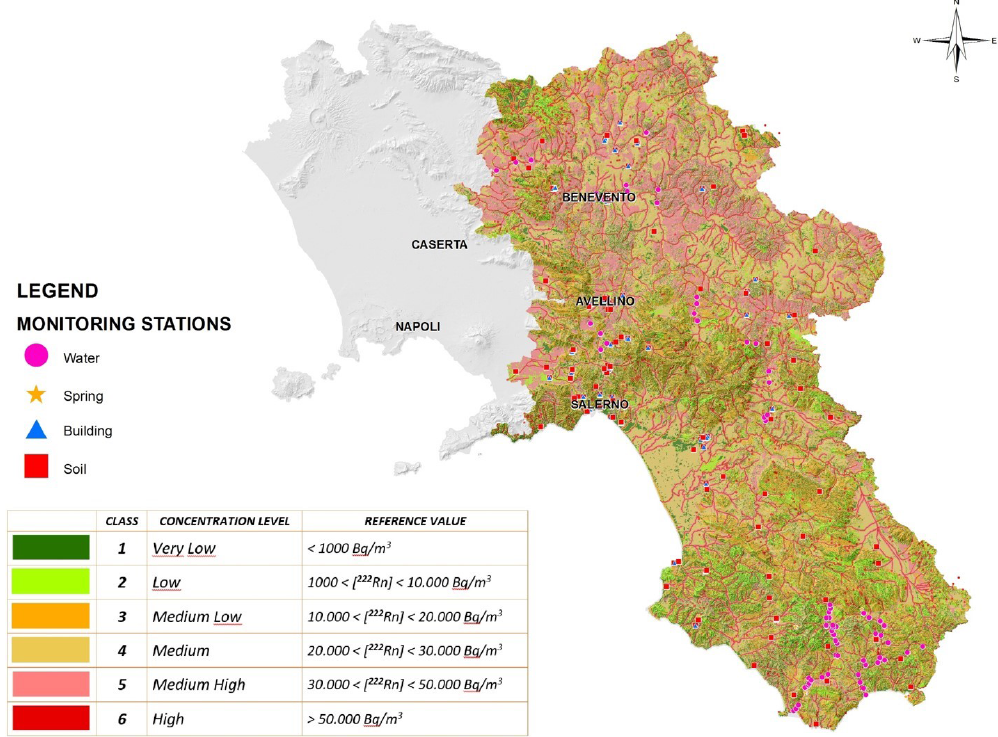
Figure 2. Campania radon potential map (including the province of Salerno, Avellino and Benevento).